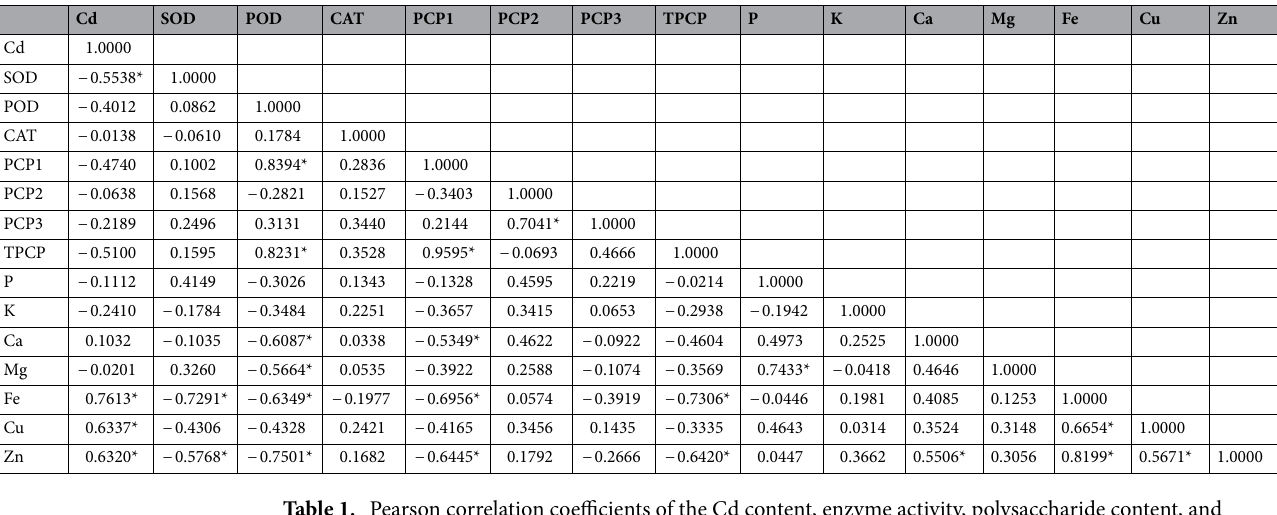
Table 1. Pearson correlation coefficients of the Cd content, enzyme activity, polysaccharide content, and mineral element content of Polygonatum sibiricum . * p < 0.05.